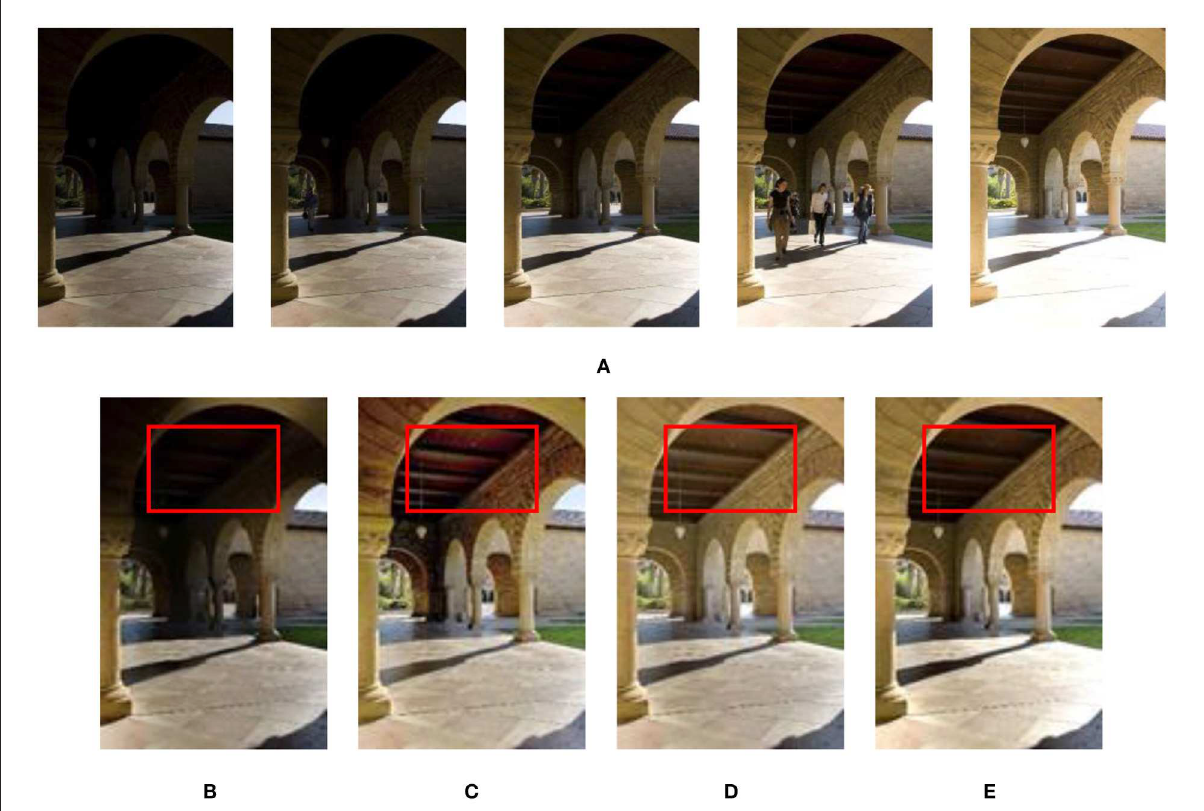
FIGURE1 Results of dynamic scene “Arch” image sequence processed with/without CRF exposure fusion framework. (A) “Arch” image sequence; (B) Without CRF exposure fusion framework processing method (Hayat and Imran, 2019); (C) ICCV image processing method (Ying et al., 2017b); (D) CAIP image processing method (Ying et al., 2017a); (E) The image processing method proposed in this